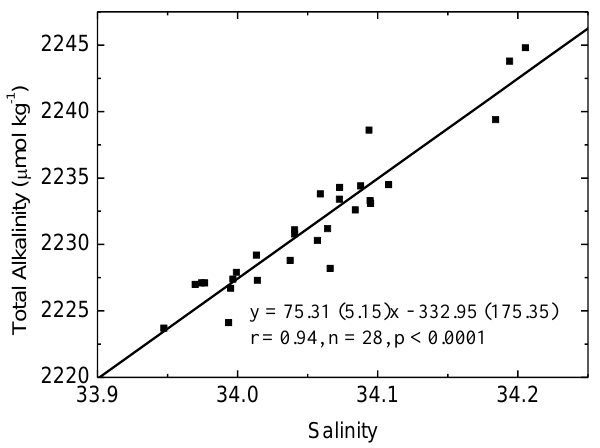
Figure 2. Relationship of total alkalinity (TA) and salinity deter- mined from the upper 20m data collected in April 2007 during the CLIVAR/CO 2 section I9N cruise (http://cchdo.ucsd.edu). (NCEP) with a spatial resolution of 2 . 5 ◦ × 2 . 5 ◦ (http://www. esrl.noaa.gov/psd/data/gridded/data.ncep.html) for calculat- ing of CO 2 fluxes. Sc is the Schmidt number, which was cal- culated based on the formula of Wanninkhof